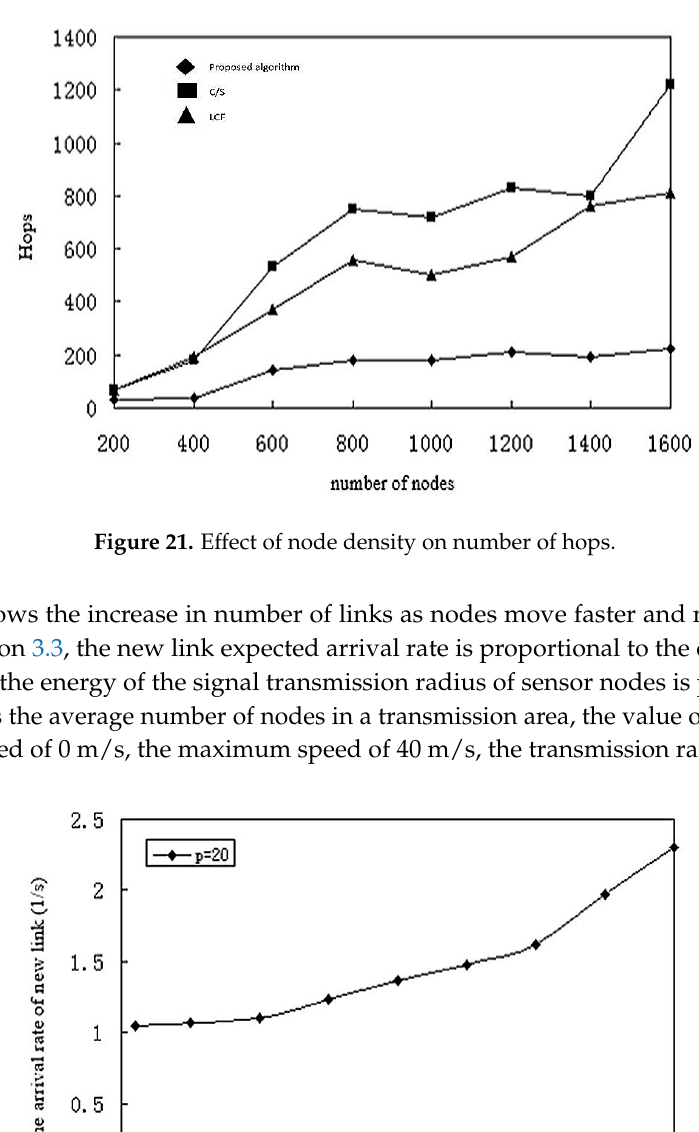
Figure 22. The expected arrival rate of nodes with different speeds.